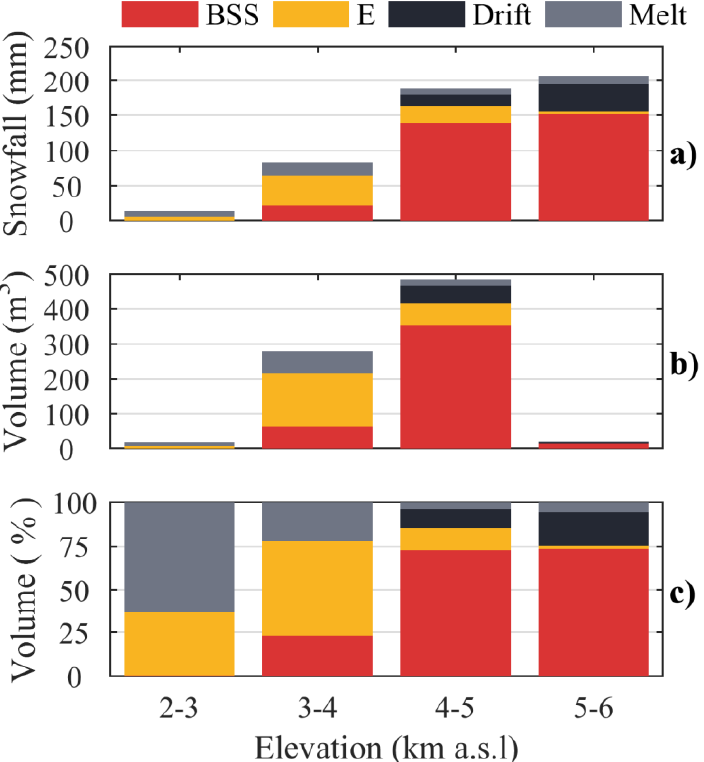
Figure 9. Annual average amount ( a ) and volume (amount times the area) ( b ) of the snow mass balance component by HRU ranges of elevation in the Copiapó basin, between 1 April 2000 and 1 April 2016. The volume is portrayed as snow water equivalent ( b ) and as percentage of snowfall ( c ). BSS: blowing snow sublimation and E: surface sublimation.